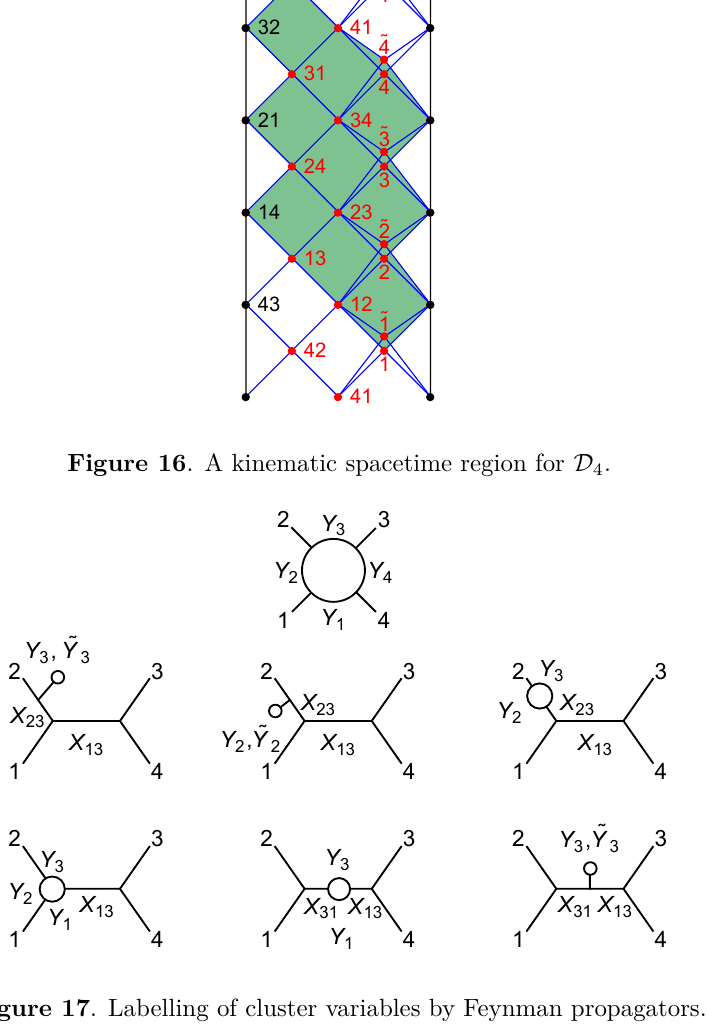
Figure 17 . Labelling of cluster variables by Feynman